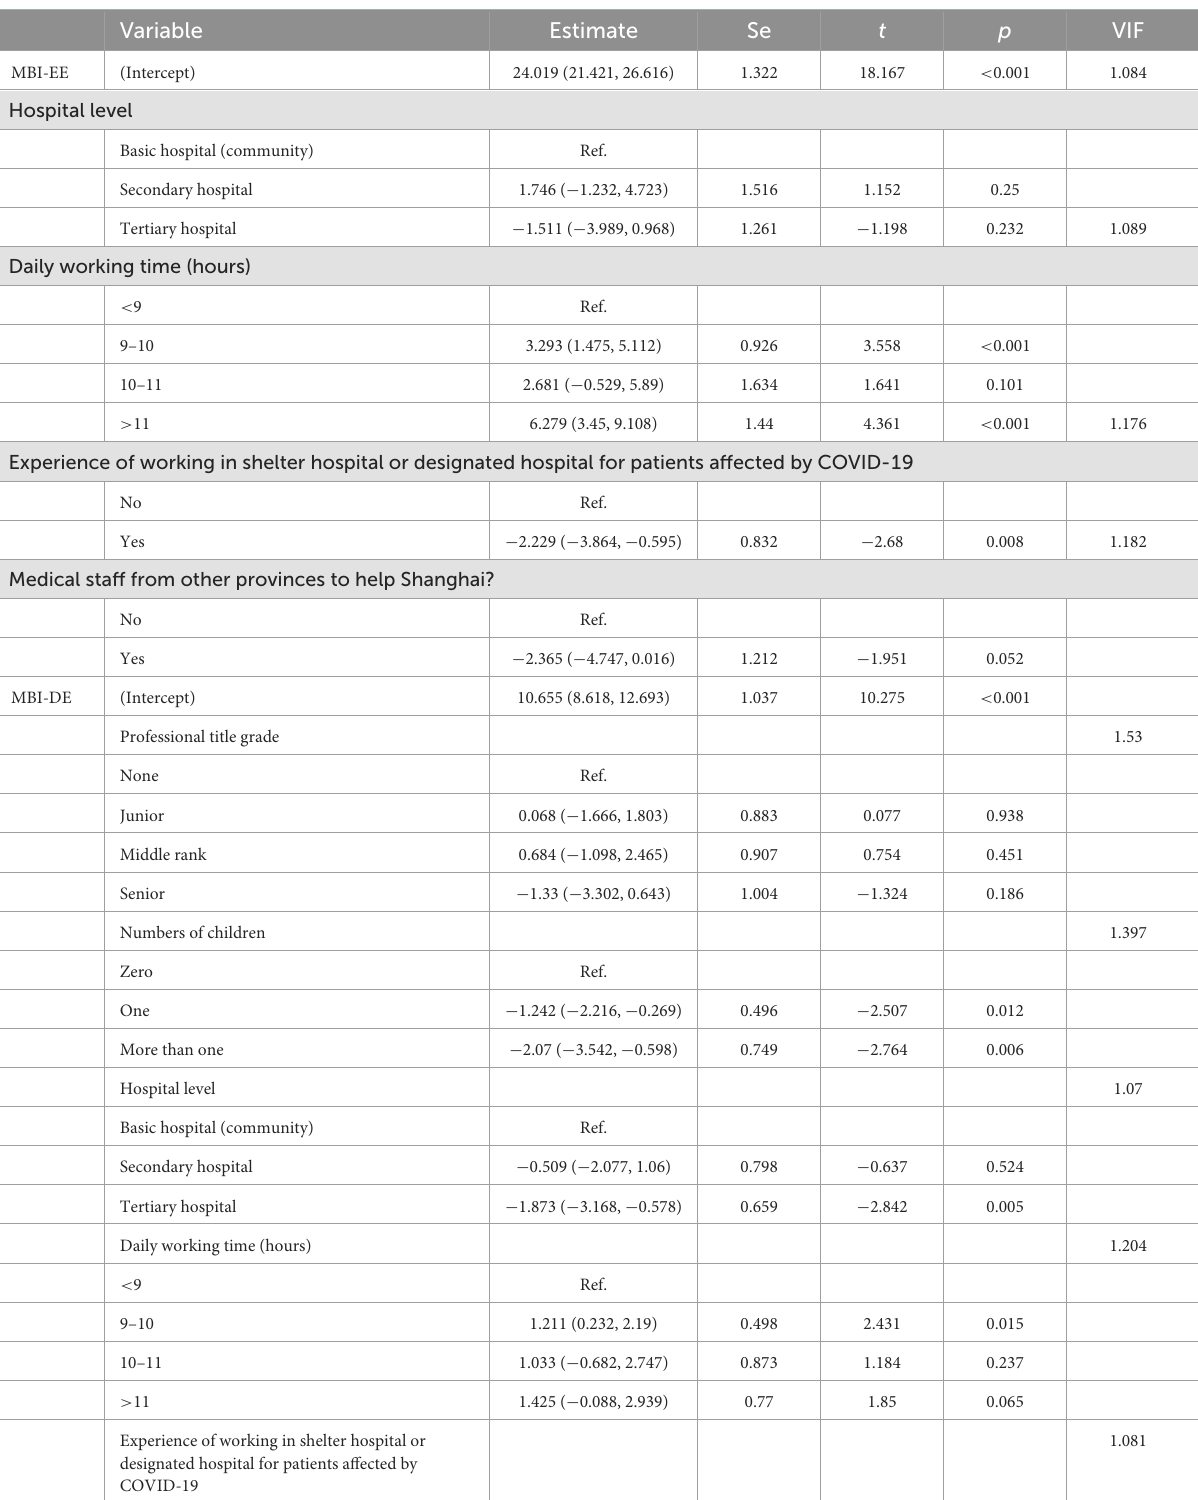
TABLE 5 Multivariate analysis of job burnout, mental health and sleep status of medical workers in Shanghai. Variable Estimate Se t p VIF